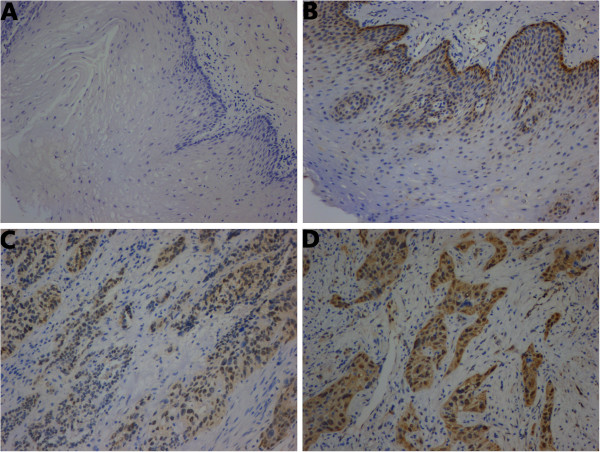
Immunohistochemical analysis of HSPA2 in ESCC samples, adjacent non-cancerous tissues and normal esophageal tissues (original magnification × 100). (A) Representative negative staining of HSPA2 in normal esophageal tissues. (B) Weak staining of HSPA2 in adjacent non-cancerous tissues. (C) Representative moderate staining and (D) strong staining of HSPA2 in ESCC tissues. The expression of HSPA2 was detected in cells of the basal layers of the esophagus (B), and HSPA2-positive staining was predominantly observed in the nucleus and some occurred in the cytoplasm in ESCC tissues (C,D). ESCC, esophageal squamous cell carcinoma.